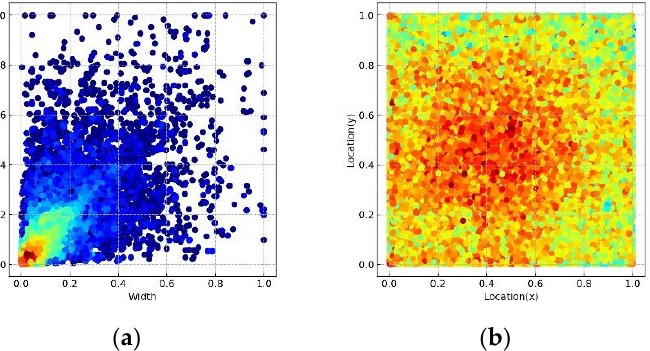
Figure 8. Heat maps of the DOTA dataset distribution. ( a ) The horizontal coordinate indicates the width of the object, and the vertical coordinate indicates the height of the object; ( b ) the horizontal coordinate indicates the x -coordinate of the object after normalization, the vertical coordinate indicates the y -coordinate of the object after normalization.